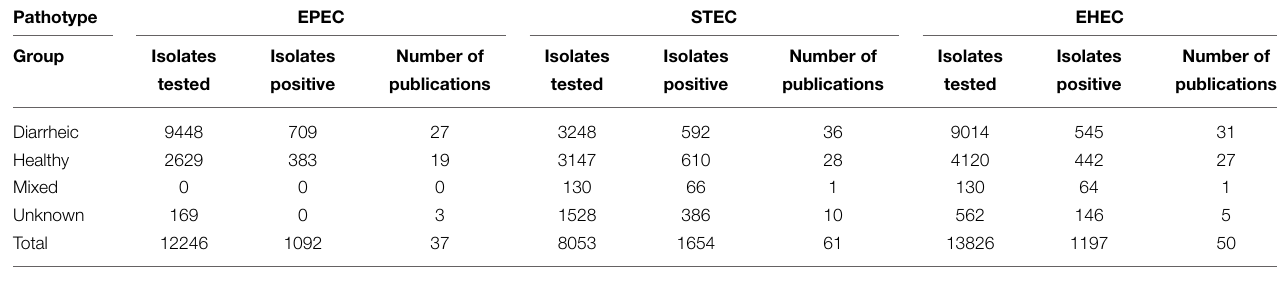
TABLE 3 | Data about EPEC, STEC, EHEC.